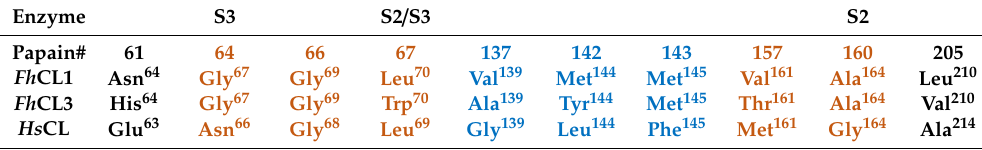
Table 2. Comparing the residues present in Fh CL1 (blue) and Fh CL3 (orange) that interact with compound C17 between the F. hepatica enzymes and the Hs CL (PDB code: 1MHW). Residues are numbered according to papain (PDB code: 9PAP) as they appear in Figure 7, and the number corresponding to each enzyme is shown in superscripts. We indicated above if the residues belonged to the subsites.